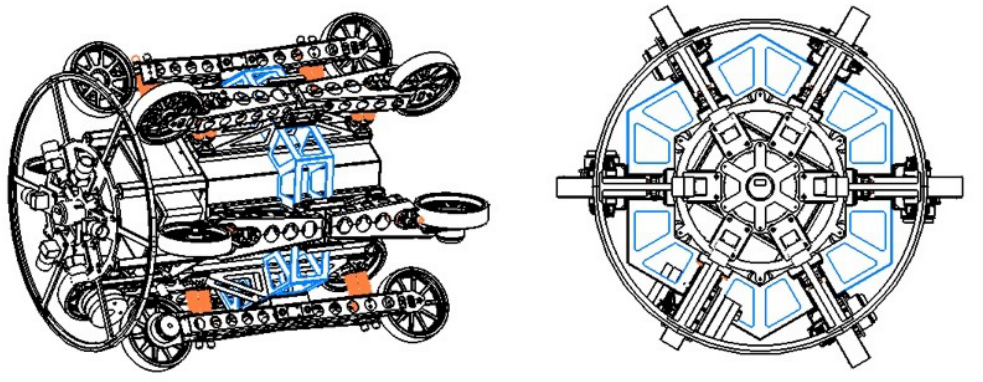
Figure 4. New design of oil pipeline inspection robot.